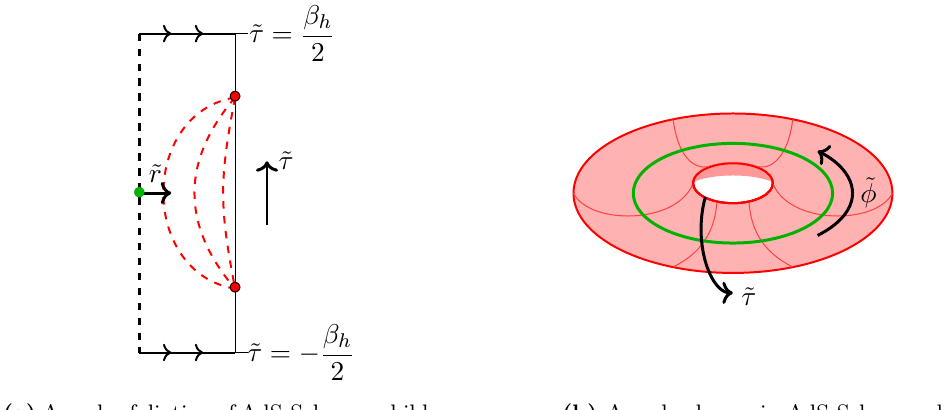
Figure 22. (a) A slice of the annular foliation of Euclidean AdS-Schwarzschild with the spherical directions fixed and the center point of the ˜ τ -cycle blown-up to a vertical line. ˜ τ increases upward while ˜ r increases outward. The ends ˜ τ = ± β h / 2 are identified. (b) The bulk configuration ob- tained by selecting a leaf of the annular foliation as an end-of-the-world brane, with the transverse ( ˜ ψ 1 , . . . , ˜ ψ d − 2 ) coordinates fixed. The central green line is the non-contractible horizon. Each given leaf partitions the bulk into a piece containing the horizon and a piece not containing the horizon. Keeping the horizon corresponds to T > 0 , and excising the horizon corresponds to T < 0